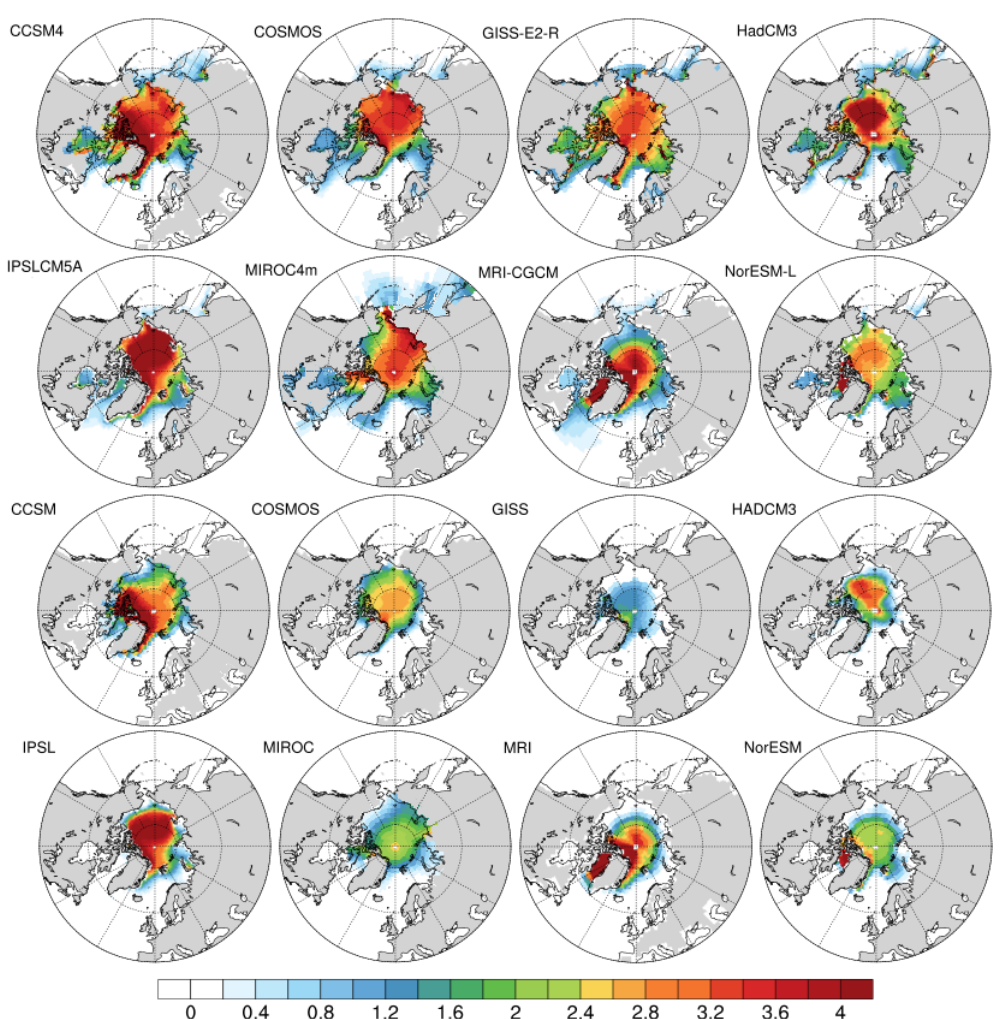
Figure 3. Mean sea ice thicknesses (m) for winter (FMA, upper half) and summer (ASO, lower half) in the pre-industrial control simulations for each PlioMIP Experiment 2